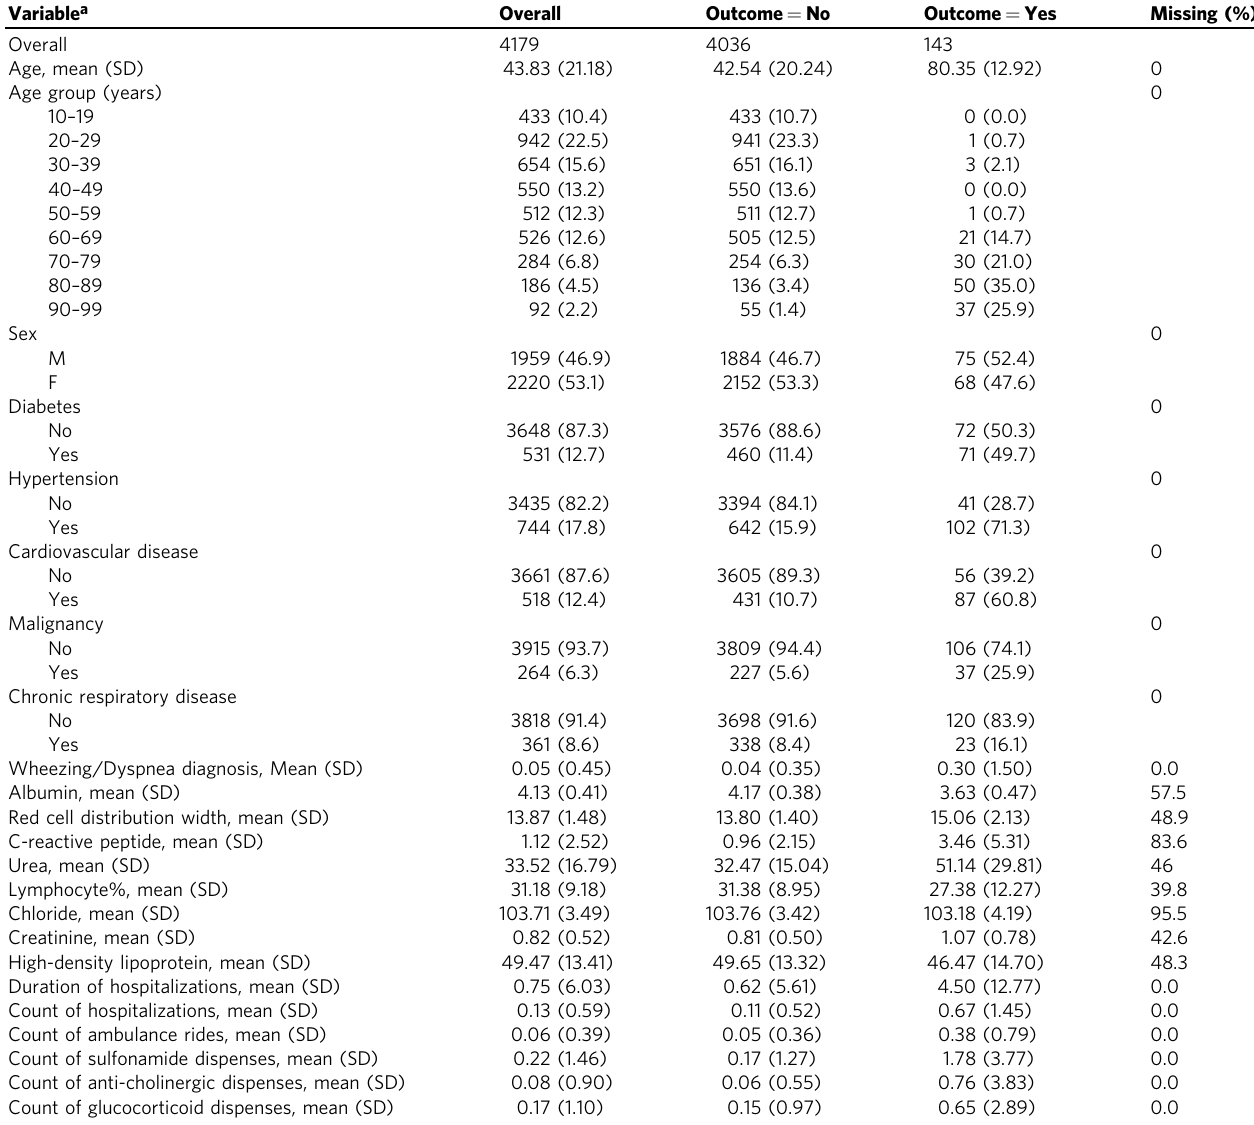
Table 1 COVID-19 patient population characteristics table. Variable a